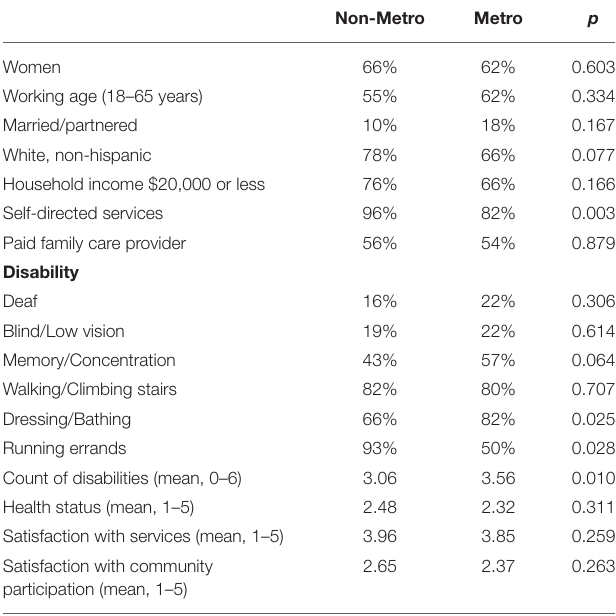
TABLE 1 | Sample descriptive statistics by non-metro/metro